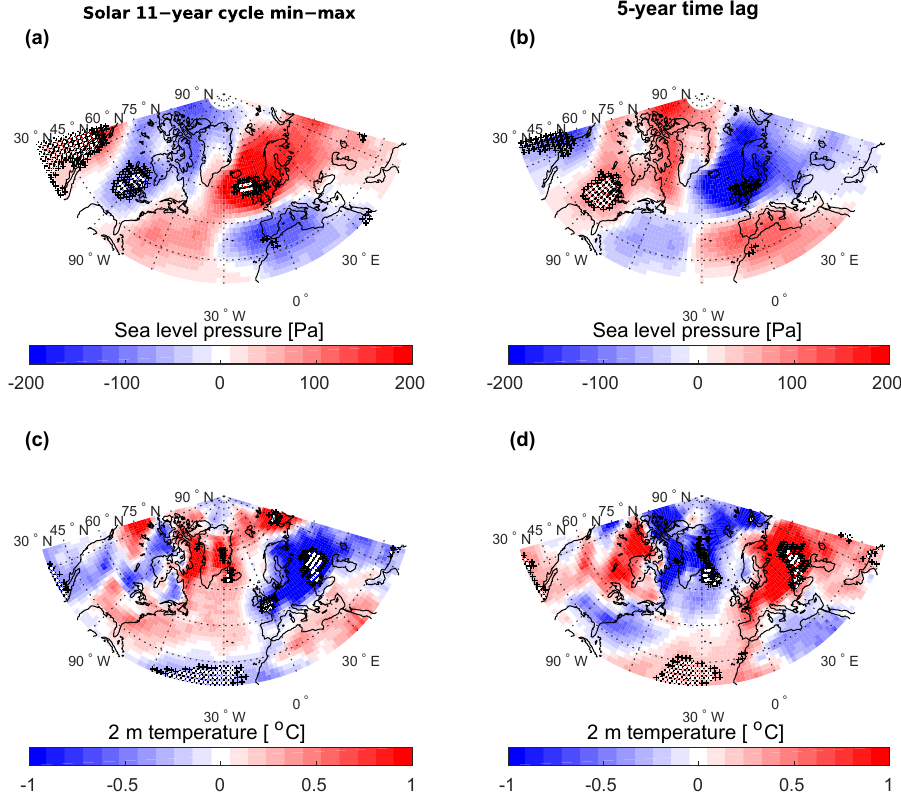
Figure 6. 20CR (1948–2010) atmospheric response to solar forcing. (a) DJF SLP anomalies (Pa) in response to the 11-year solar cycle (solar min. minus solar max. defined in Fig. S12). (b) DJF SLP anomalies (Pa) in response to the 5-year lagged 11-year solar cycle (solar min. minus solar max.). (c, d) corresponding figures to (a, b) , but for T2m ( ◦ C). The white stippling indicates significant anomalies p < 0 . 05, and black stippling indicates significant anomalies p < 0 . 1 (two-tailed Student’s t test). The time interval for this analysis in limited to 1948–2010